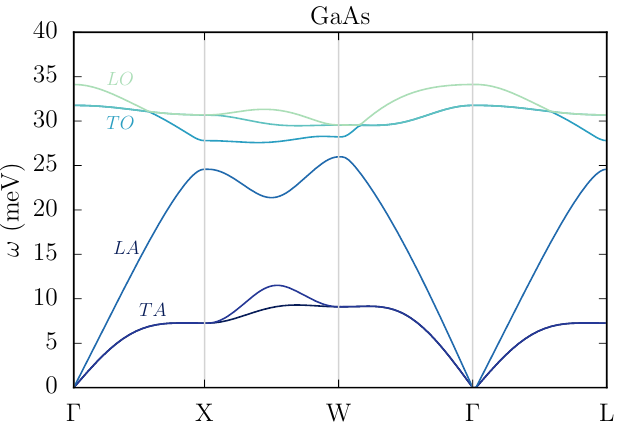
and M , with respective displace- 1 2 and w . This lattice has both a longitudinal acoustic and i i / M = 1.5. 2 1